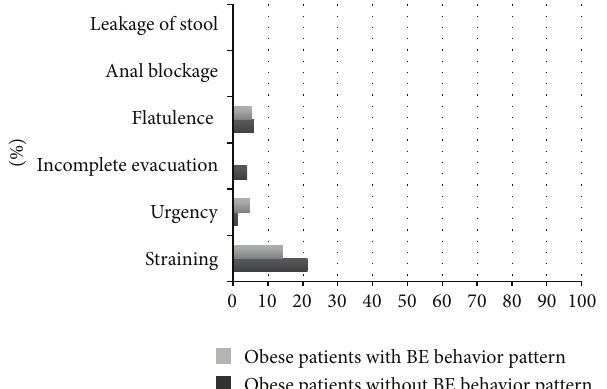
Figure 4: Prevalence of abdomino-pelvic symptoms such as leakage of stool, anal blockage, flatulence, incomplete evacuation, urgency, and straining in obese patients with and without BE behavior pattern. Data are expressed as percentages